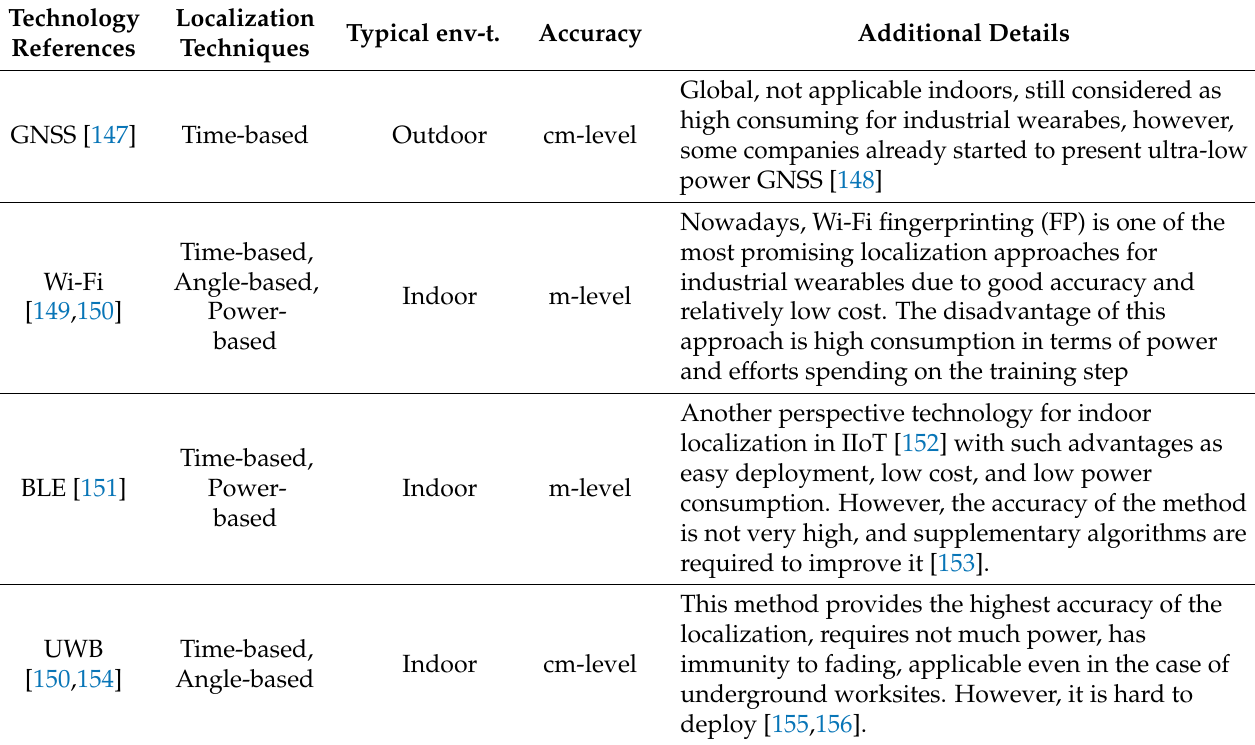
Table 6. Comparison of localization